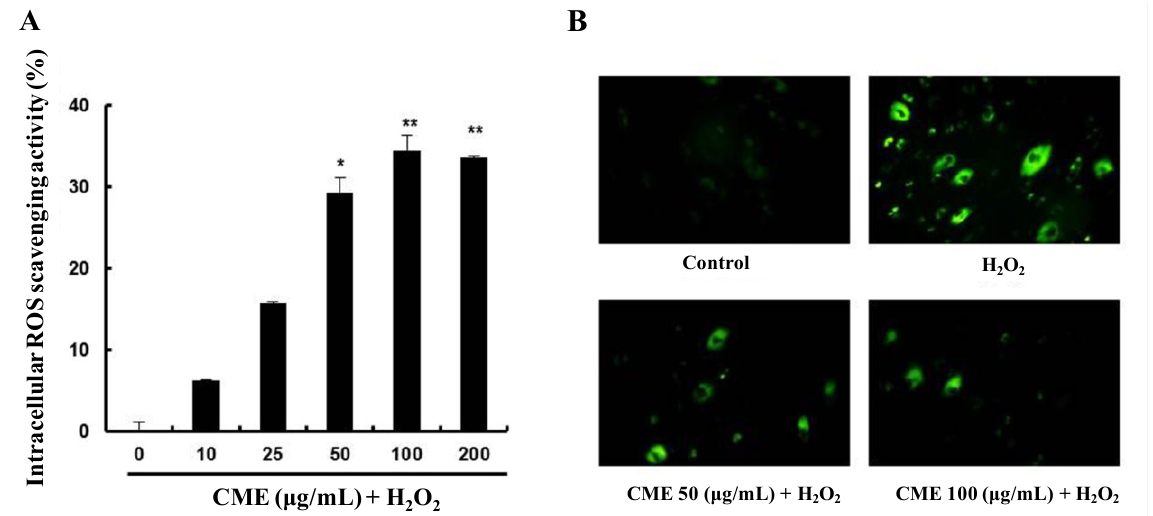
Figure 4. Intracellular reactive oxygen species (ROS) scavenging activity of CME in HDFs. ( A ) CME was added at 10–200 μg/mL for 4 h followed by addition of 0.8 mM H 2 O 2 for 3 h. Intracellular ROS scavenging activity was measured using the H 2 DCF-DA method. Data represent the mean ± SE of three independent experiments. The significance of differences between H 2 O 2 alone group and CME-treated groups was assessed using Student’s t -test. ** p < 0.01. ( B ) Representative fluorescence images illustrating the increase in green fluorescence intensity of DCF produced by ROS in H 2 O 2 -treated cells as compared to control and cells treated with CME. The conditions were control (no treatment), 0.8 mM H 2 O 2 for 3 h, 0.8 mM H 2 O 2 for 3 h with 50 μg/mL of CME, and 0.8 mM H 2 O 2 for 3 h with 100 μg/mL of CME. Magnification: